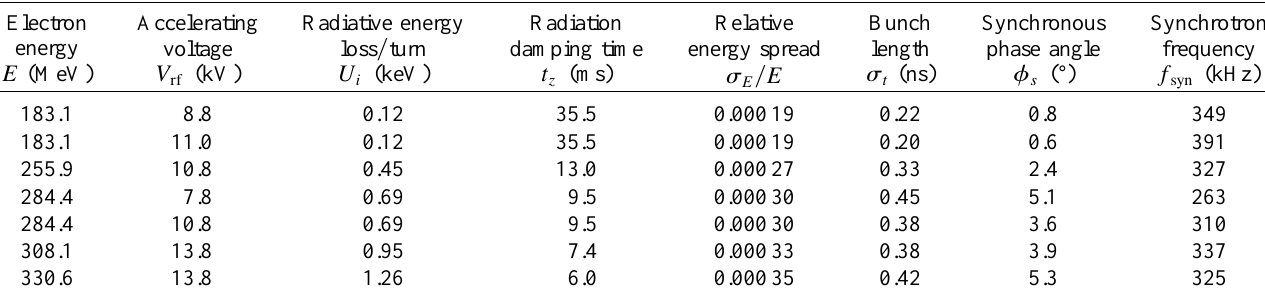
TABLE I. Accelerator parameters for the SURF III machine conditions studied. The values in the table are calculated based on the energy and accelerating voltage. The measured rms bunch length is typically 40% greater than the natural value, and the measured synchrotron frequency is about 5% higher than the theoretical values listed.